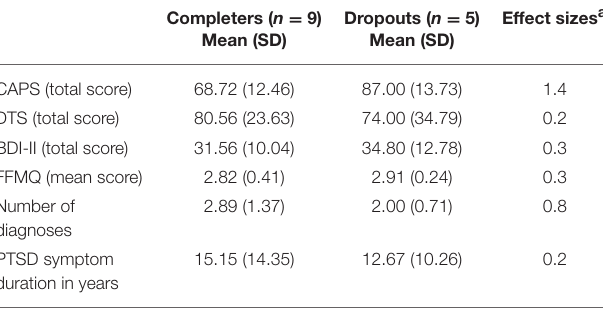
TABLE 3 | Comparison of baseline characteristics between completers and dropouts: means, standard deviations and effect